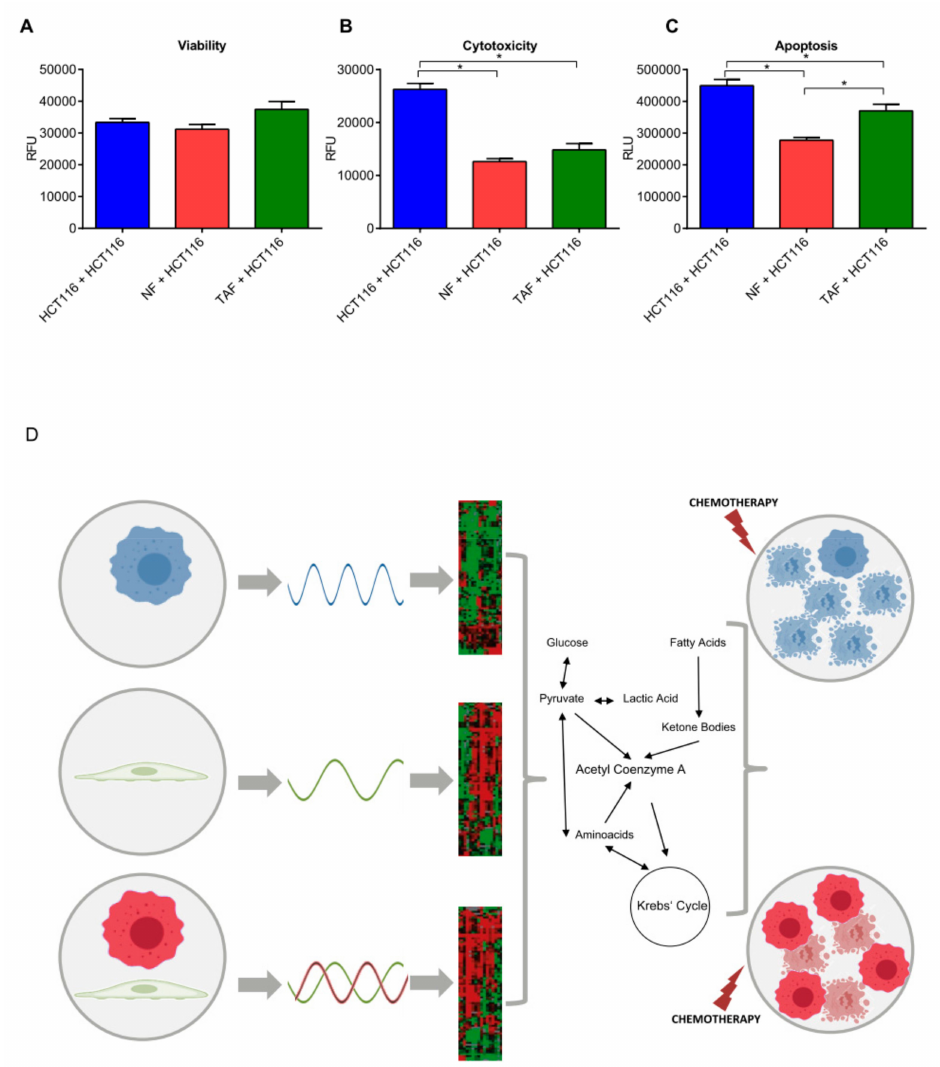
Figure 7. Cell-to-cell communication impacts cancer cell phenotype. ( A ) Viability, ( B ) cytotoxicity, and ( C ) apoptosis in HCT116 cells cultivated alone or after co-culture with NF or TAF. Only HCT116 cells were measured. Data are represented as mean ± SEM ( n = 5). Statistically significant values ( p < 0.05) are indicated with *. ( D ) The interaction of cancer cells (top left) with stromal cells (middle left) impacts their circadian phenotype, determines transcriptome modifications, and governs metabolic re-wiring to influence the response to